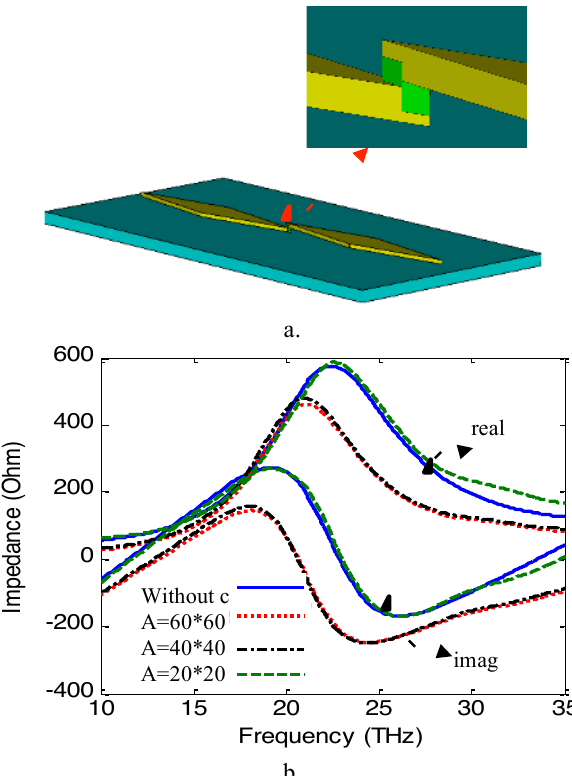
b. Figure 14. A rhombic dipole IR - nanoantenna on a dielectric substrate overlapped area to cons truct MIM diode , b. The impedance variation versus frequency for rhombic dipole IR - nanoantenna on a dielectric substrate without overlapping area and with different overlapping area using insulator of 𝜀 =8. !